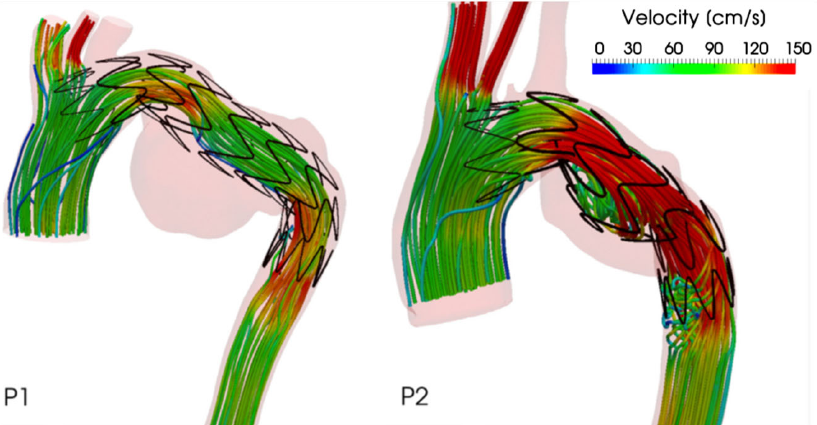
Figure 9. Predicted velocity streamlines with stent ‐ grafts being virtually deployed into two arch aneurysms. Figure was adopted from [85], Copyright (2022), with permission from